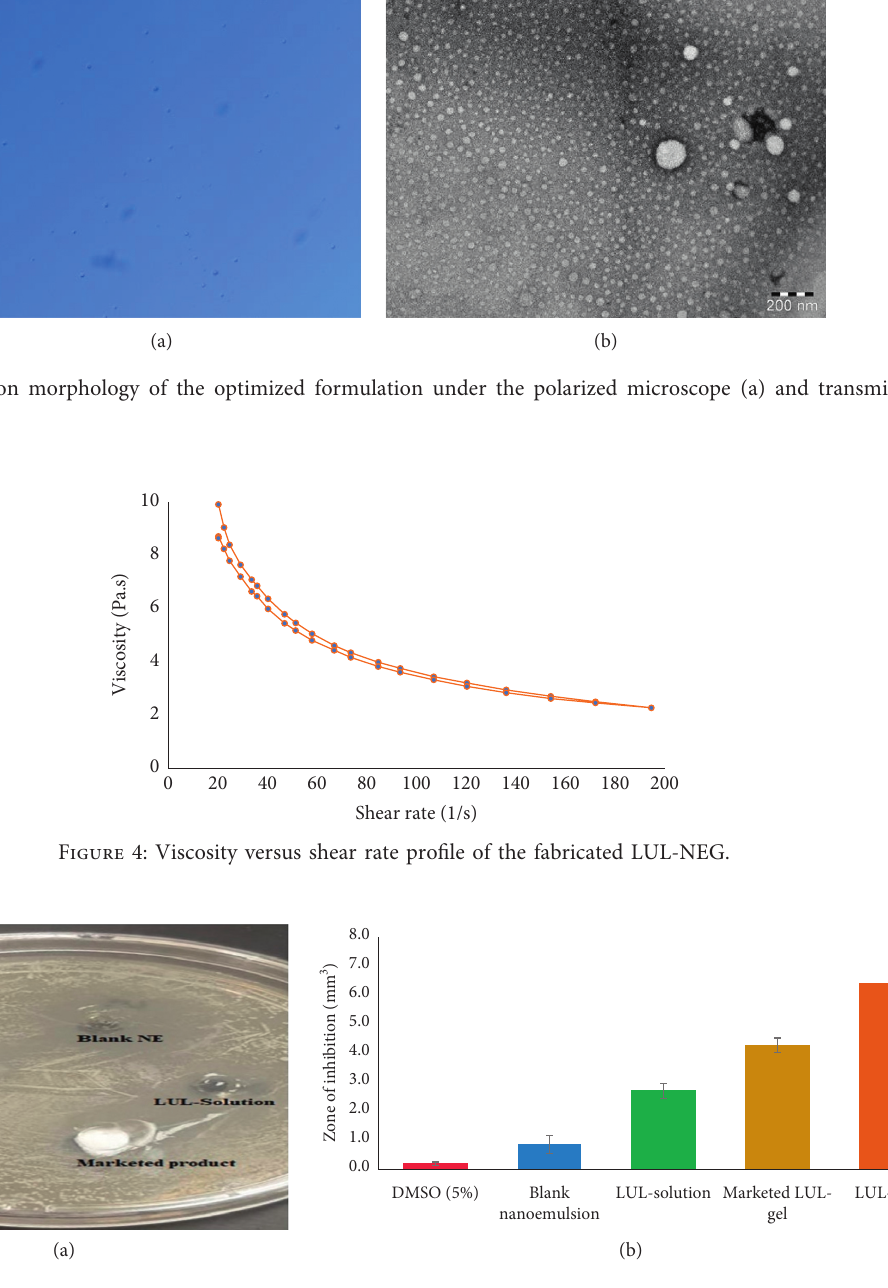
Figure 5: Areas of zone of inhibition in the tested samples in the Petri dish containing Candida albicans (a) and the presentation of the measured area of the zone of inhibition of different groups (b). The results were presented as mean ± SD ( n � 3). ∗ P <